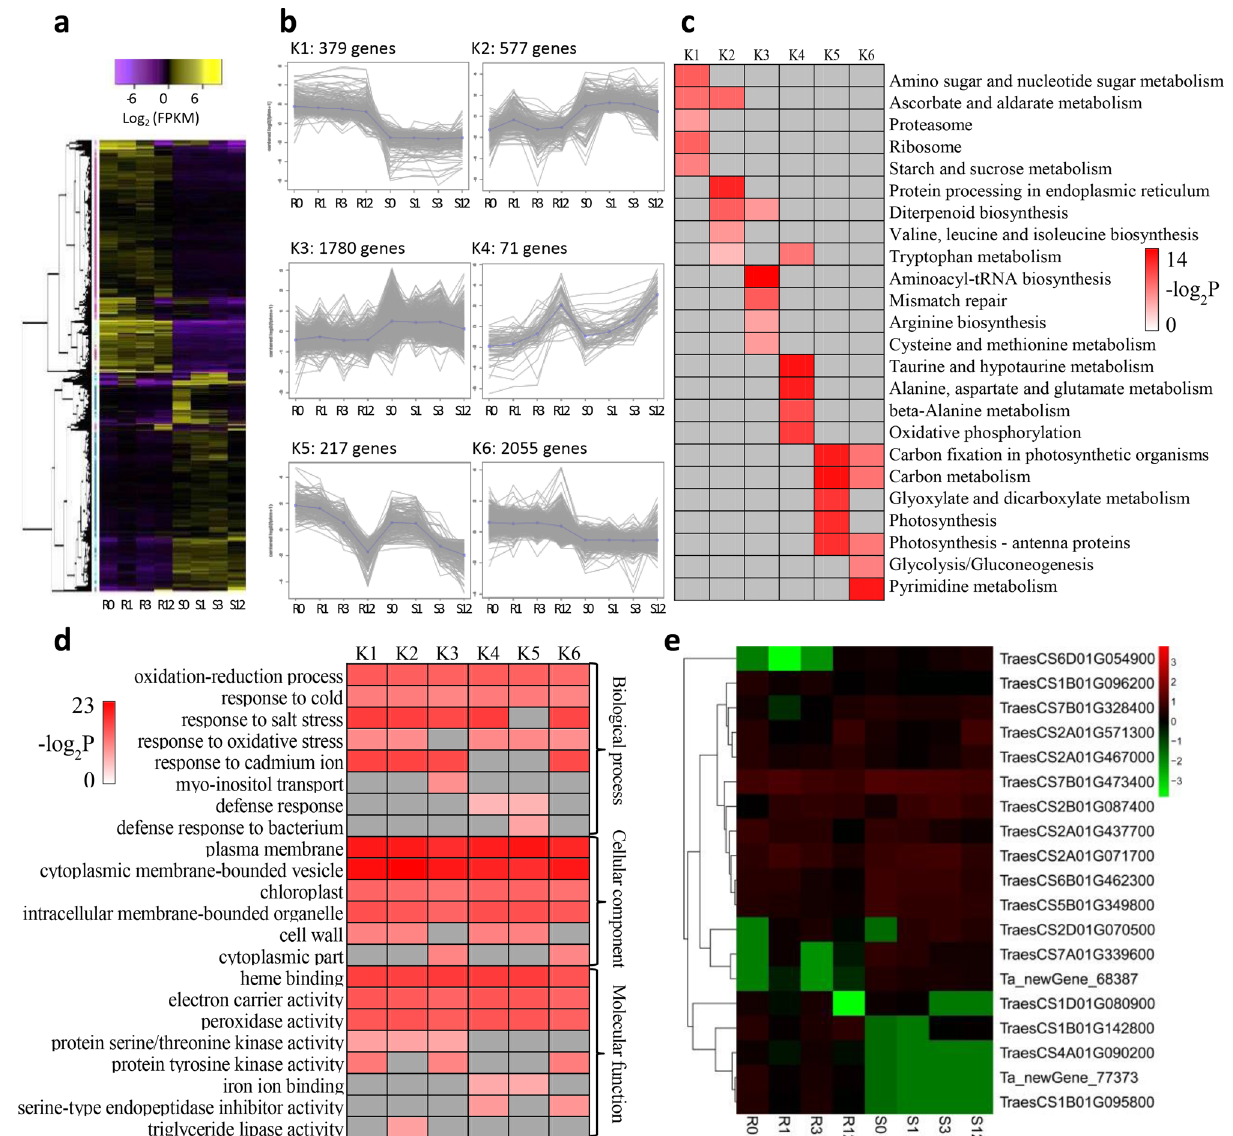
Figure 4. Overview of serial analysis of differentially expressed genes (DEGs) identified by pairwise comparisons between slightly and highly susceptible wheat lines at 0, 1, 3 and 12 days after inoculation with Bipolaris sorokiniana . ( a ) Heatmap of all DEGs among four timepoint samples for both lines. Expression values were presented as log 2 -transformed normalized FPKM values. ( b ) The six clusters (K1 to K6) for DEGs. ( c ) Top five enrichment pathways of the DEGs in different clusters, referring to the KEGG database. ( d ) Top five enrichment terms of the DEGs in different clusters, referring to GO database. The significance of the most represented pathways in each main cluster are indicated using -log 2 -transformed P -value (red); dark grey areas represent missing values. ( e ) Heat map of the 19 DEGs included in peroxidase activity (GO:0004601). R and S are the slightly susceptible (SN4143) and highly susceptible (PZSCL6) line, respectively. ( a,b,e ) were performed using BMKCloud (www. biocl oud.